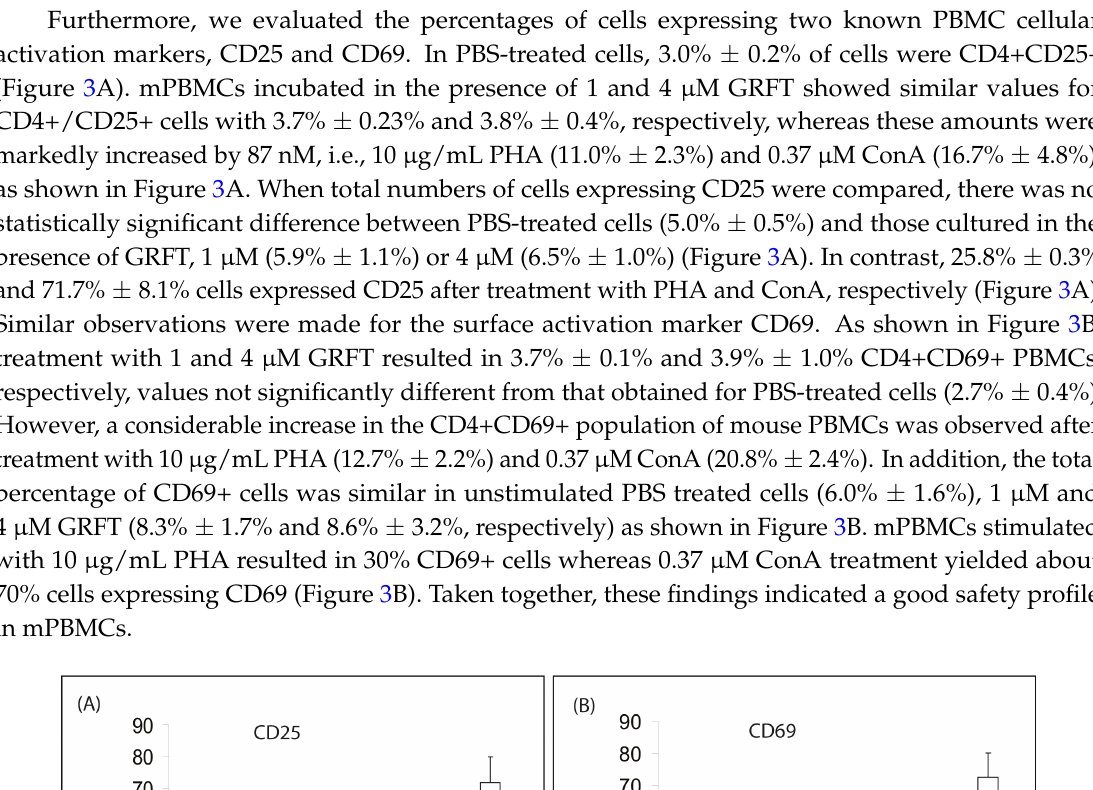
Figure 2. Mitogenic properties of GRFT on mPBMCs. Cells were cultured for three days in the presence of PBS ( A ); 1 and 4 μ M GRFT (( B , C ), respectively); 0.37 μ M ConA ( D ) and 10 μ g/mL phytohemagglutinin (PHA) A ( E ). Dot plots reveal forward scatter (FSC) and side scatter (SSC) of